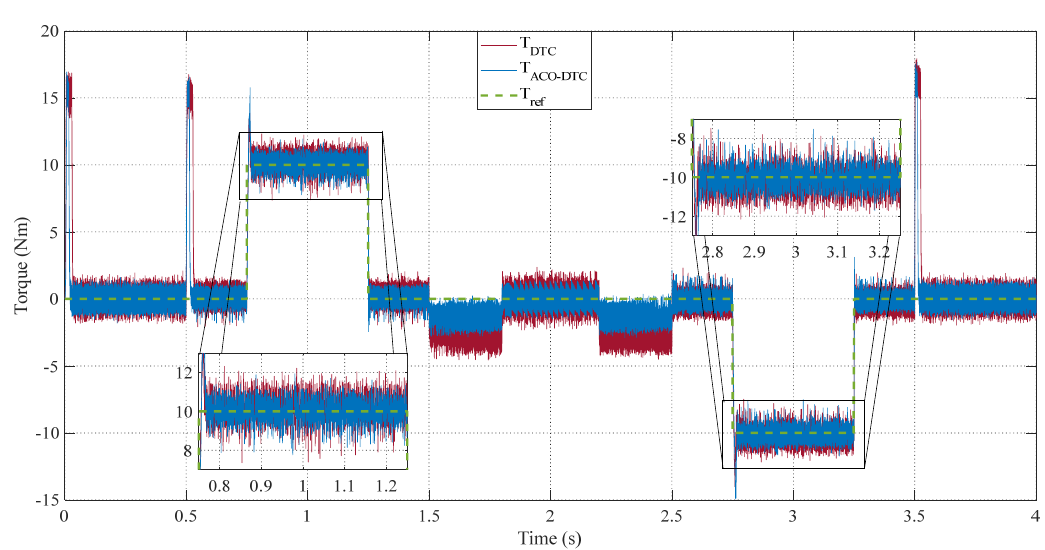
Figure 12. Torque responses of classical DTC and intelligent ACO-DTC.